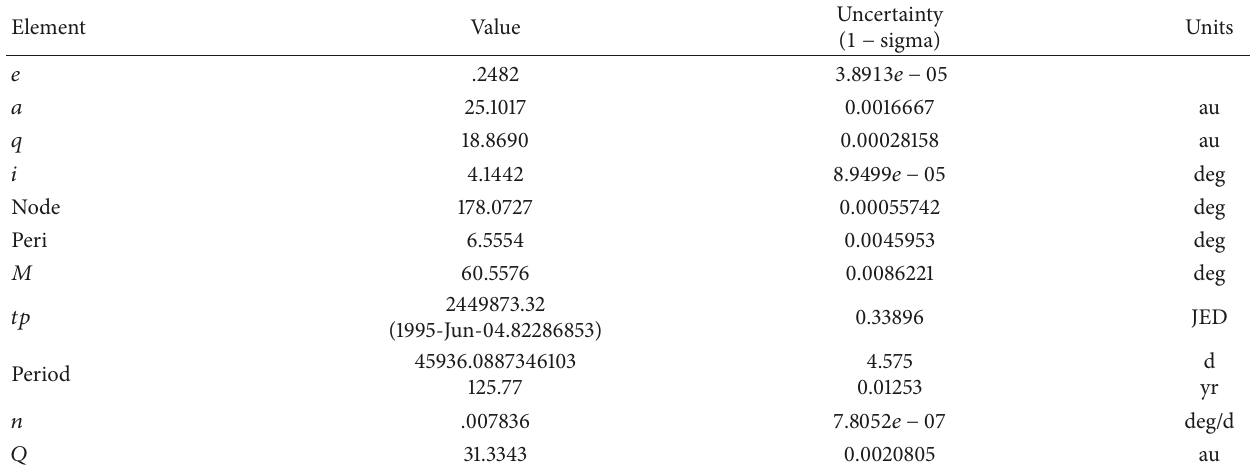
Table 5: Orbital characteristics of Hylonome.